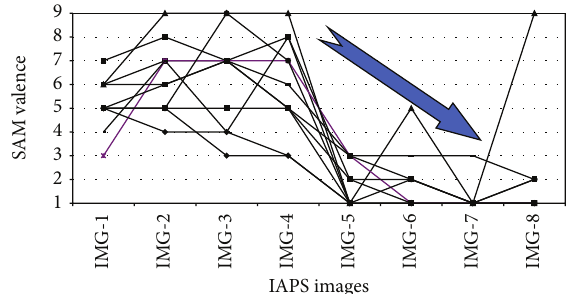
Figure 2: Valence assigned by participants to IAPS selected images.